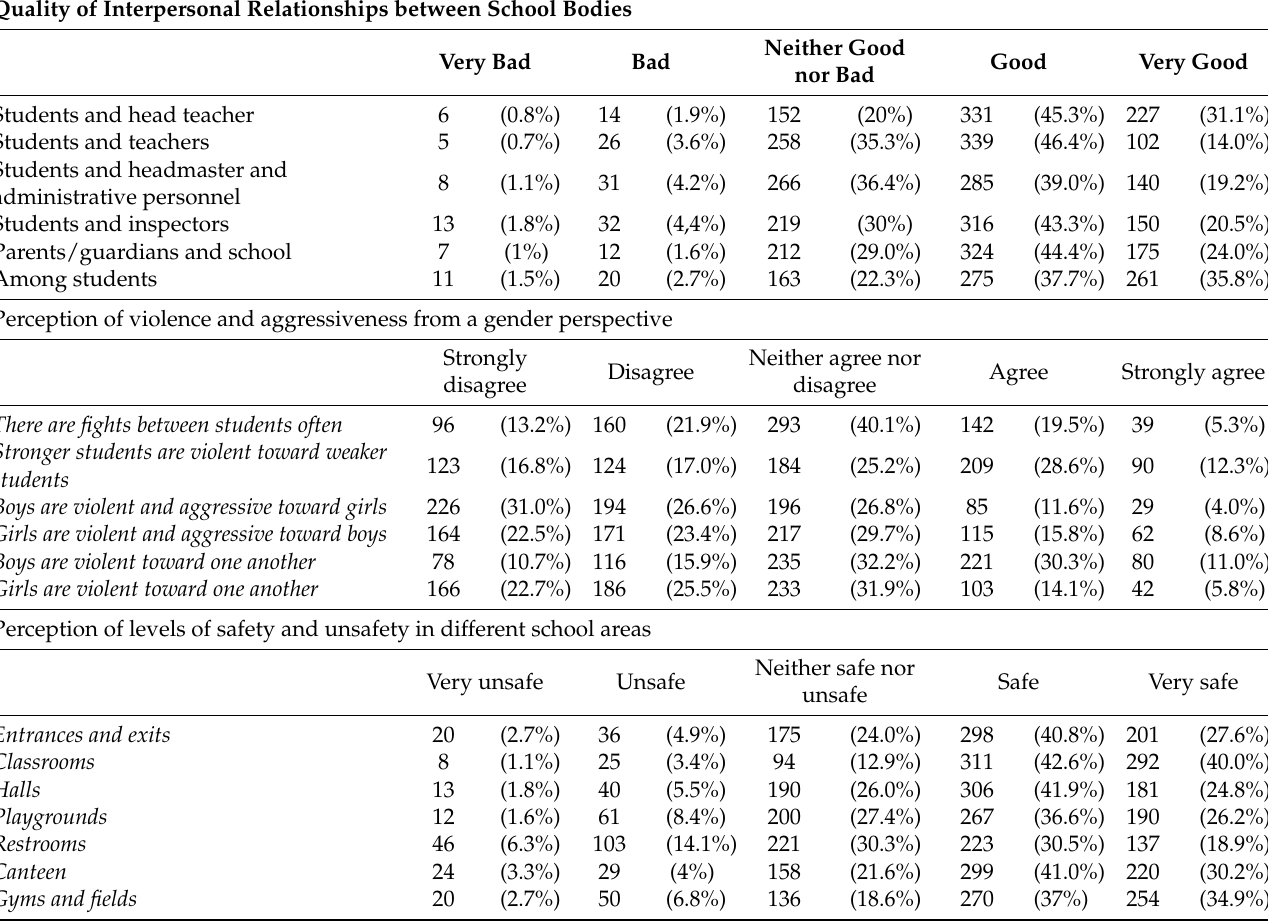
Table 2. School coexistence indices such as the quality of interpersonal relationships between school bodies, the perception of violence and aggressiveness from a gender perspective, and the perception of levels of safety and unsafety in different school